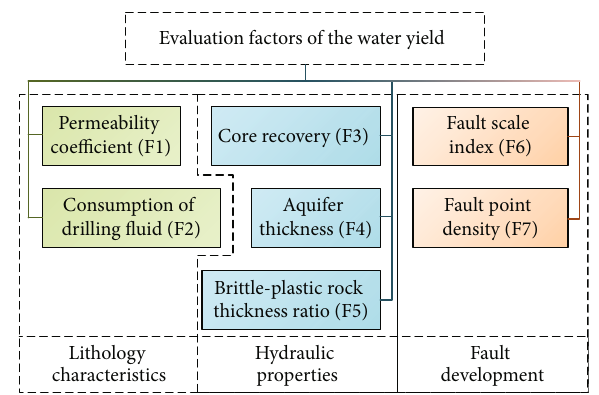
Figure 3: Major controlling factors of the water yield